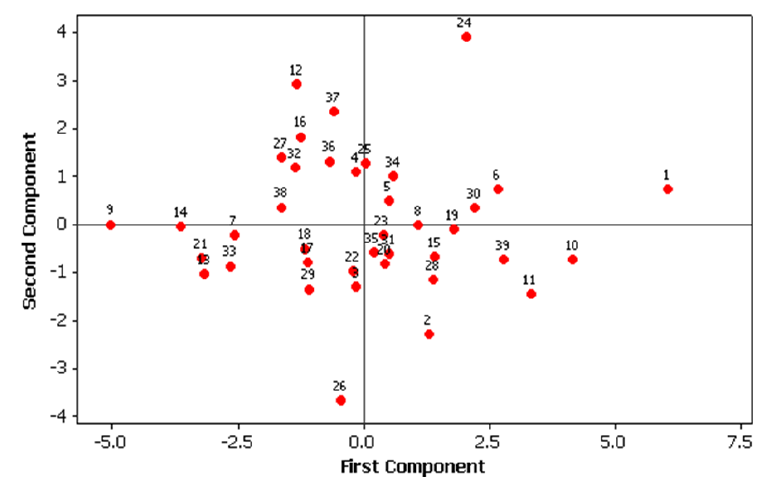
Fig. 3. Cultivars distribution biplot based on two first component for 2/3 continuous irrigation 1-‘Shiroodi’; 2-‘Aria’; 3-‘Darya’; 4-‘10’; 5-‘Kiknejad’; 6-‘Atila4’; 7-‘Akbari’; 8-‘Gods’; 9-‘Sepehan’; 10-‘Atila50’; 11-‘Sistan’; 12-‘Moghan1’; 13-‘Karaj3’; 14-‘Bahar’;